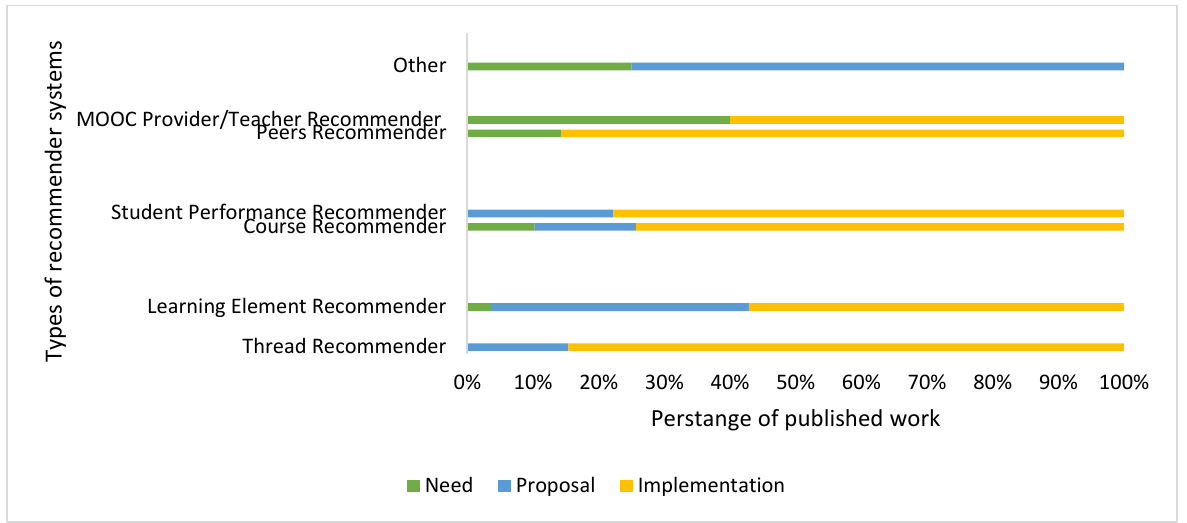
Figure 8 . Proportion of literature categorized with respect to type of recommendation and type of